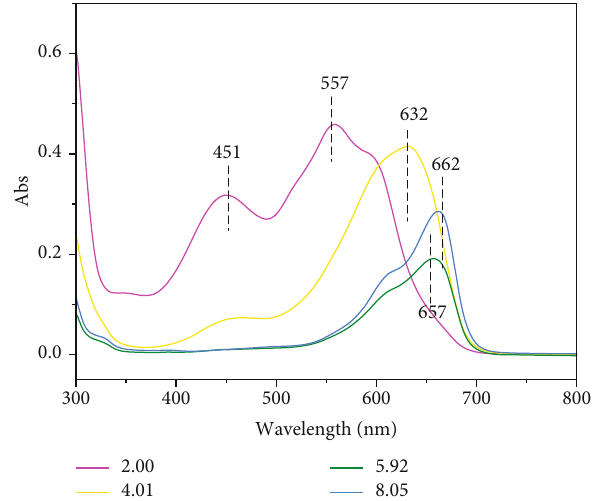
Figure 5: Trend of the release of Mn 2+ during the reaction in di ff erent pH.